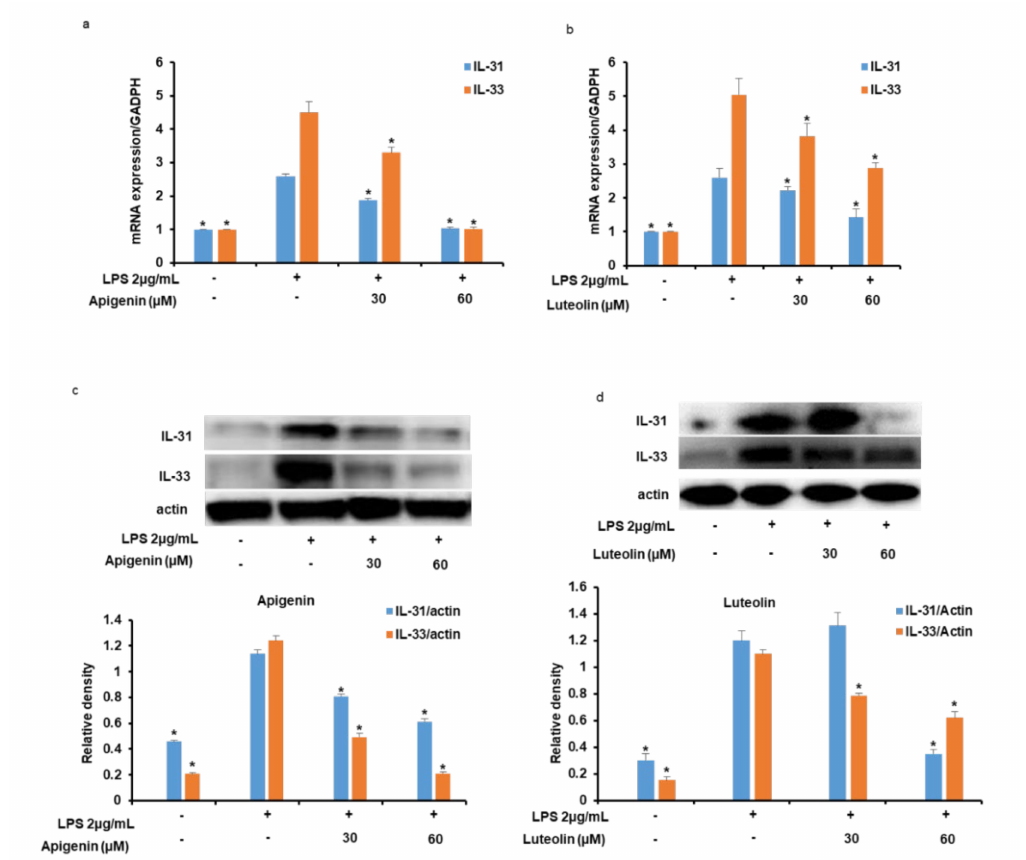
Figure 3. Apigenin and luteolin inhibit LPS-induced intracellular expression of IL-31 and IL-33 mRNA and protein expressions. Microglia cells (5 × 10 5 cells / mL) were cultured and pre-treated with apigenin or luteolin at the concentrations of 30 and 60 µ M and then stimulated with LPS for 3 h ( a , b ) or 12 h ( c,d ). The mRNA expressions of IL-31 and IL-33 were investigated by quantitative real-time PCR analysis ( a,b ). The protein expression levels of IL-31 and IL-33 was investigated via western blot assay and the band densities were analyzed using ImageJ analysis software, with respect to actin ( c,d ). The results are presented as the mean ± SD ( n = 3). The asterisk (*) indicates a significant di ff erence at p < 0.05 compared to the LPS-only treated cells for bars with the same color. GADPH: Glyceraldehyde 3-phosphate